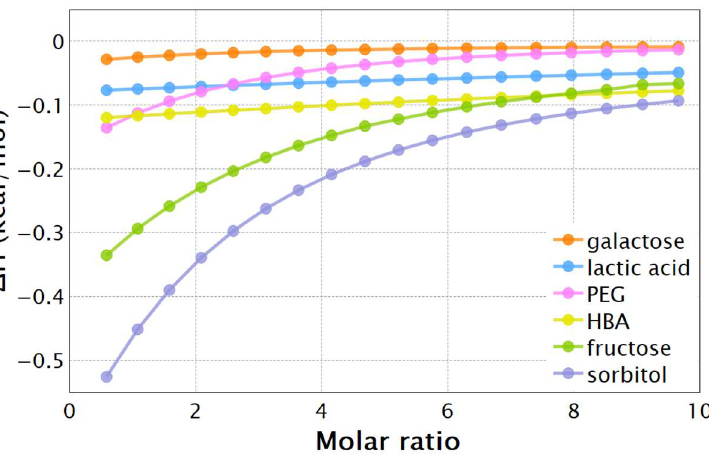
Figure 2. Normalized heat plot measured for binding of different compounds to TBA. Titration conditions: 300 μL of 0.5 mM TBA in the cell and 25 mM of the corresponding compound in the titration syringe, pH 7.4.